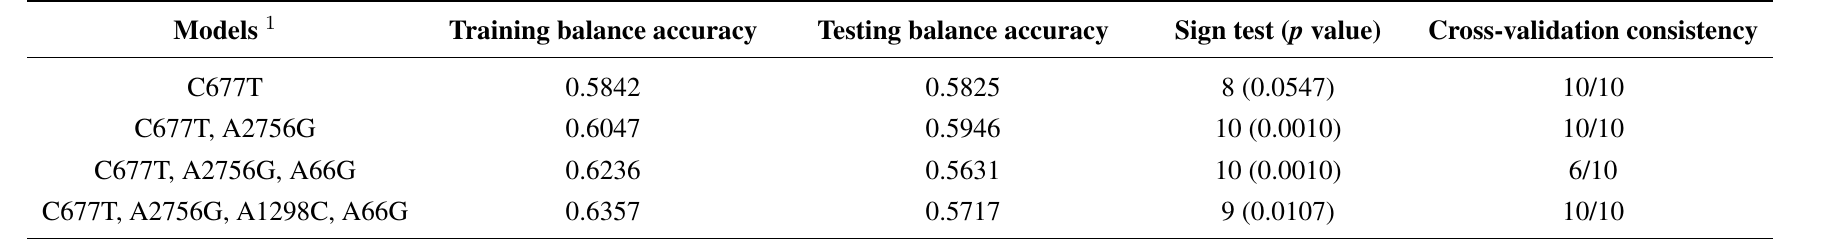
Table 6. GMDR models of effects of high-order interactions on folate deficiency.